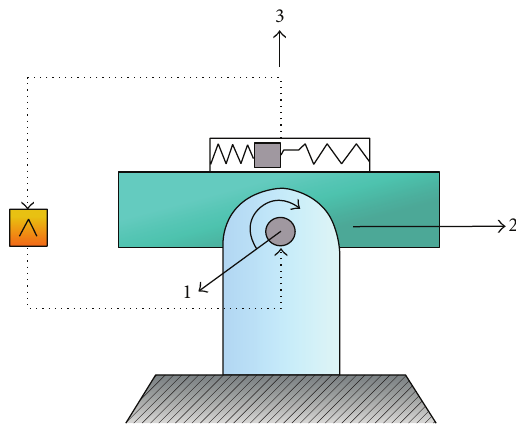
Figure 1: Physical model of the horizontal platform system.